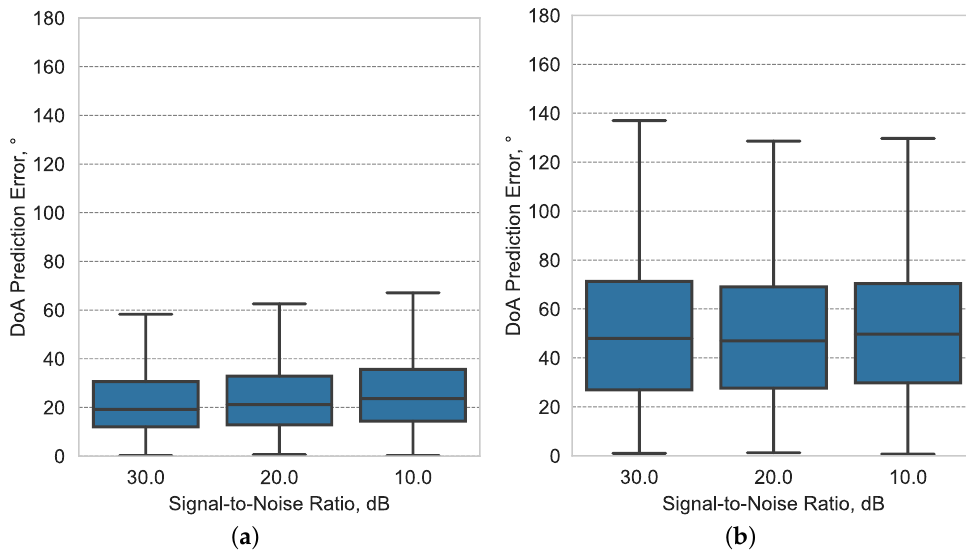
Figure 5. Angular errors of source DoA estimation at different input signal SNR values: ( a ) method; ( b ) the baseline method; Q = 5°, σ = 20.